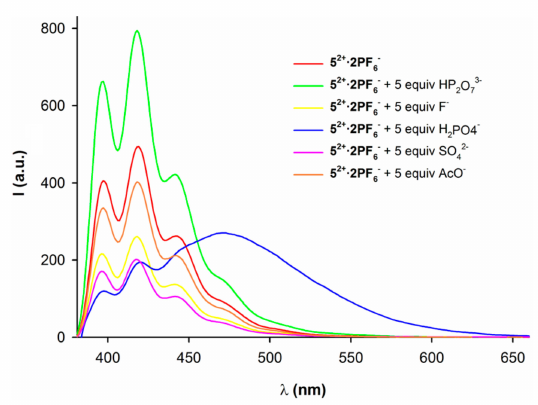
Figure 2. Emission spectrum of the receptor 5 2+ · 2PF 6 − ( c = 1 × 10 − 5 M) in CH 3 CN (red line) and after the addition of 5 equiv. of H 2 PO 4 − (blue line), SO 42 − (pink line), AcO − (orange line), HP 2 O 73 − (green line) and F − (yellow